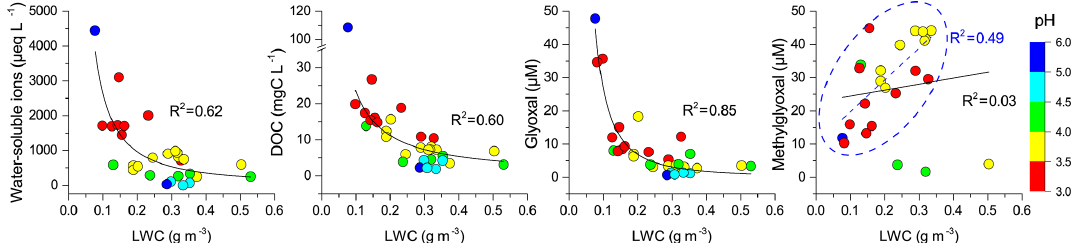
Figure 3. Relationships of water-soluble ions, dissolved organic carbon, glyoxal, and methylglyoxal with liquid water content. Color scale represents the pH range. Solid lines are empirical inverse-power fits to the data. Methylglyoxal has a good linear relationship with LWC for samples in the blue dashed circle.